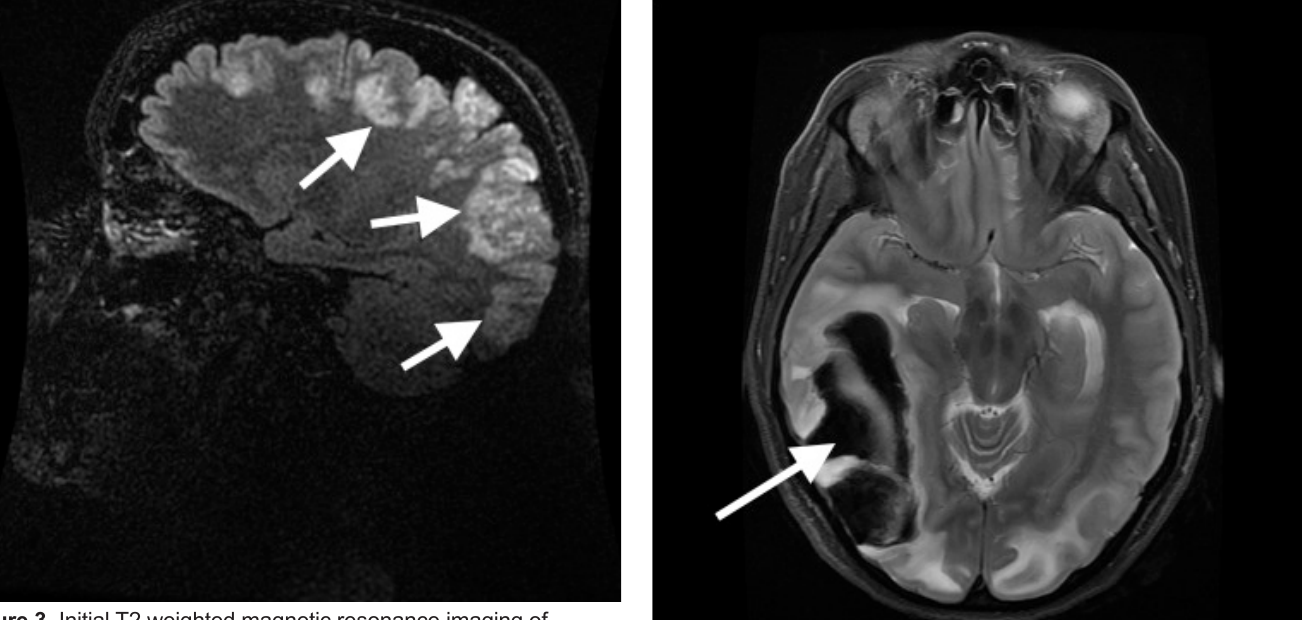
Figure 3. Initial T2 weighted magnetic resonance imaging of Patient 3 on second emergency department visit, showing increased T2 intensity throughout the cortical and subcortical gray matter of the bilateral frontal, parietal, occipital and posterior temporal lobes.